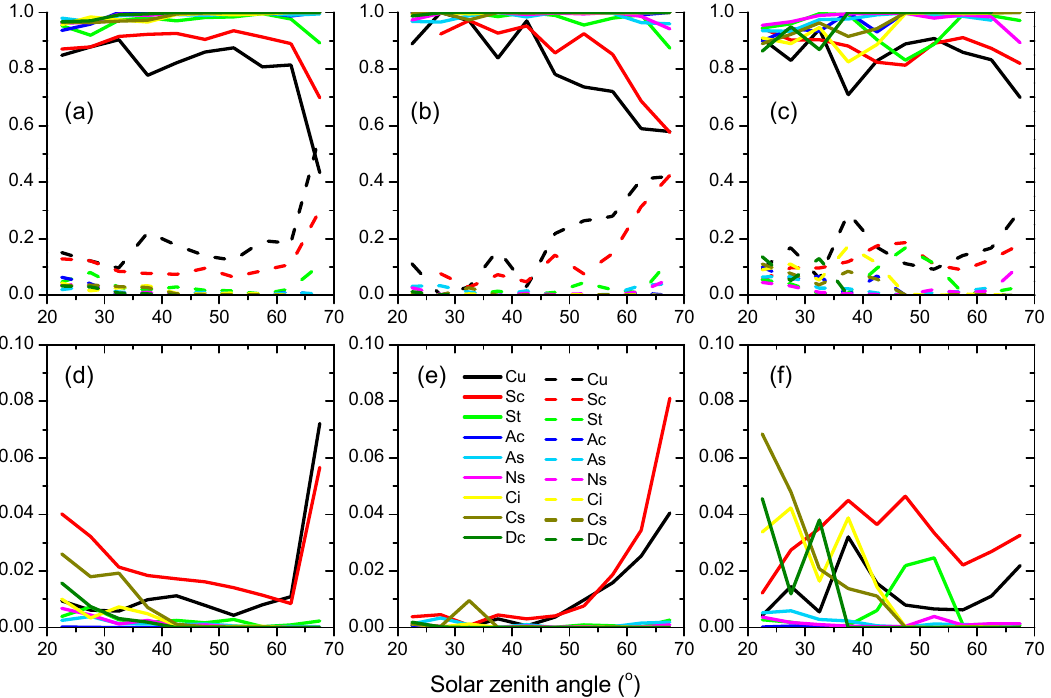
Figure 8. The variation of the proportion of consistent (solid lines) and non-consistent (dashed lines) MODIS and CALIOP cloud detection with SZA for different cloud types over ( a ) dark, ( b ) bright, and ( c ) water surfaces, respectively, and the variation of r_MODcloud_CALfree for each cloud type with SZA over ( d ) dark, ( e ) bright, and ( f ) water surfaces, respectively.